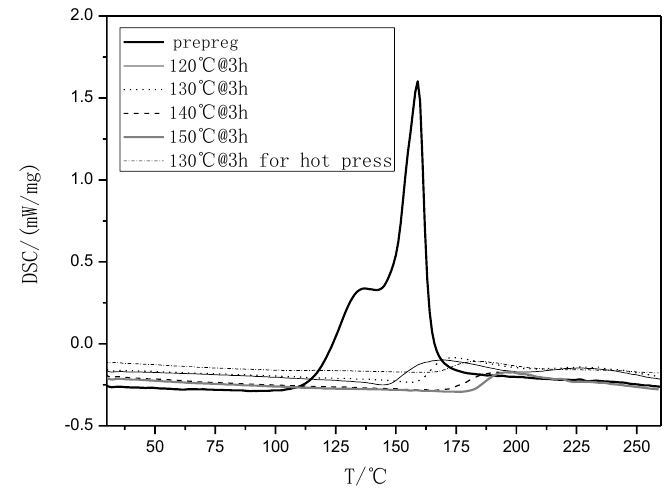
Figure 1. Differential Scanning Calorimetry (DSC) curves of the rosin-sourced epoxy resin system designated as AGMP3600 at different temperature conditions.